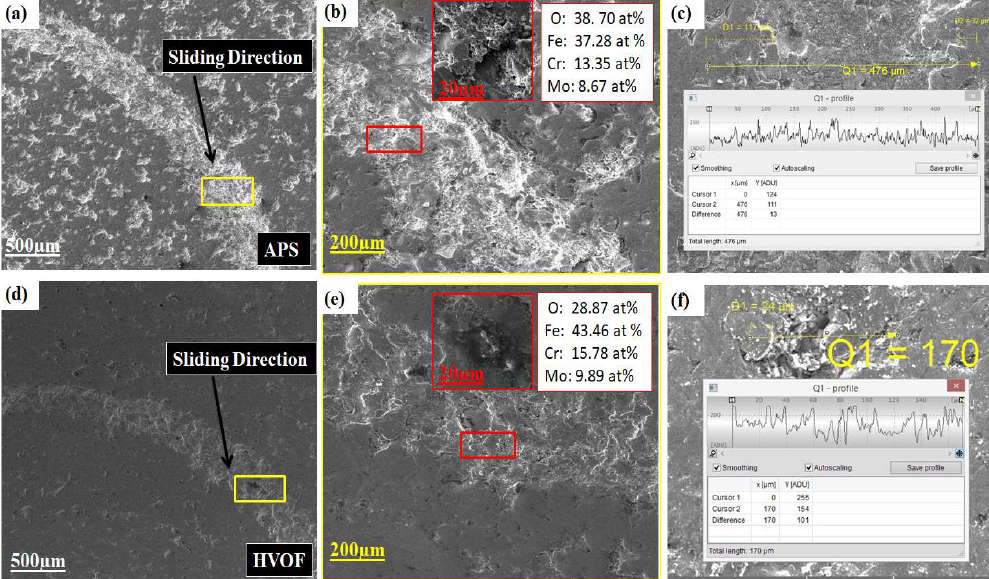
Figure 7. Wear track analysis ( a , d ). Sliding direction for APS and HVOF at 100× with 20.0 kv ( b , e ). Worn surface magnification at 300× with 20.0 kv. EDS was taken from insert image displayed at 20 µm at 2.00 kx with 20.0 kv ( c , f ). Wear track profile measurement for APS and HVOF.